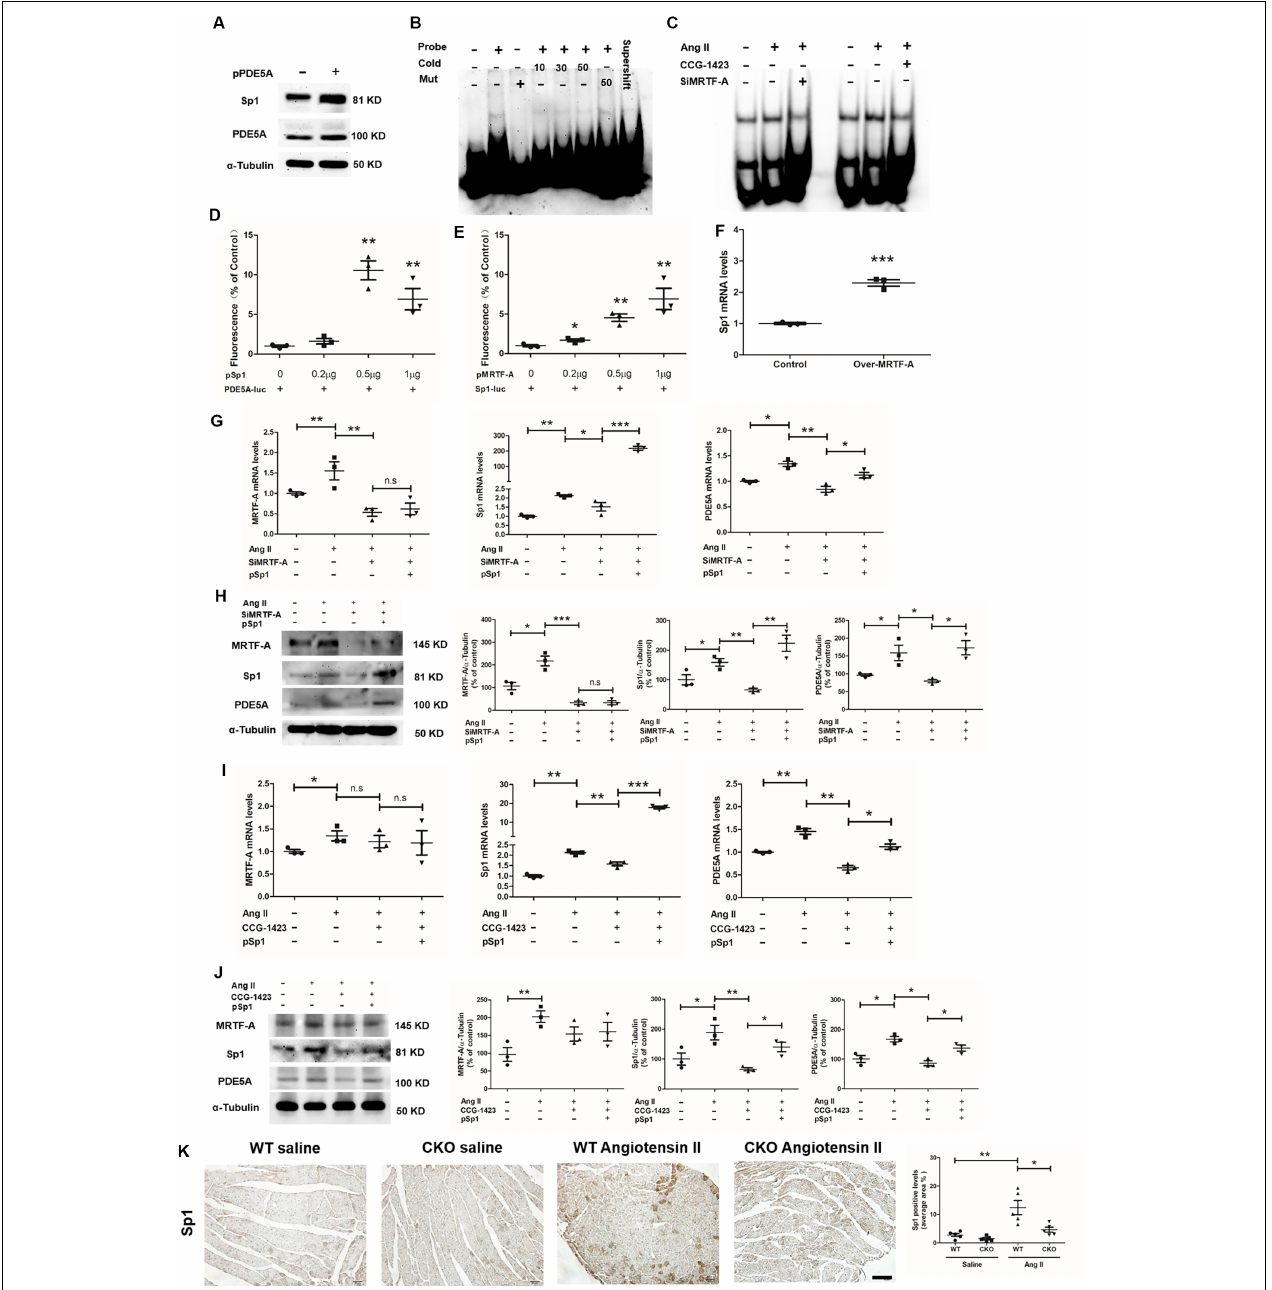
FIGURE 5 | Sp1 directly activates phosphodiesterase 5A (PDE5A) transcription in cardiomyocytes. (A) H9C2 cells were transfected with an Sp1 vector or an empty vector. Protein expression was examined by Western blot. (B) Nuclear lysates were extracted from H9C2 cells, and electrophoresis mobility shift assay (EMSA) was performed as described in section “Materials and Methods.” (C) H9C2 cells were transfected with small interfering RNA (siRNA) targeting myocardin-related transcription factor A (MRTF-A) or scrambled siRNA (SCR) followed by treatment with Ang II (1 µ M) for 24 h. Alternatively, H9C2 cells were treated with Ang II (1 µ M) and CCG-1423 (10 µ M) for 24 h. Nuclear lysates were extracted, and EMSA was performed as described in section “Materials and Methods.” (D) 293T cells were cotransfected with plasmid containing PDE5-promoter-luc and/or different concentrations of Sp1 overexpression plasmid. Luciferase report assay was performed as described in section “Materials and Methods.” (E) 293T cells were cotransfected with plasmid containing Sp1-promoter-luc and/or different concentrations of MRTF-A overexpression plasmid. Luciferase report assay was performed as described in section “Materials and Methods.” (F) H9C2 cells cotransfected with plasmid overexpression MRTF-A, Sp1 expression was examined by quantitative PCR (qPCR). (G,H) H9C2 cells were transfected with siRNA targeting MRTF-A or scrambled siRNA (SCR) in the presence or absence of ectopic Sp1 followed by treatment with Ang II (1 µ M) for 24 h. Gene expression was examined by qPCR and Western blot. (I,J) H9C2 cells were treated with Ang II (1 µ M) and CCG-1423 (10 µ M) in the presence or absence of ectopic Sp1 for 24 h. Gene expression was examined by qPCR and Western blot. (K) Immunohistochemistry (IHC) staining of cardiac sections with anti-Sp1 antibodies. Data represent averages of three independent experiments, and error bars represent SEM. * p < 0.05; ** p < 0.01; *** p < 0.001. Scale bar: 50 µ m.